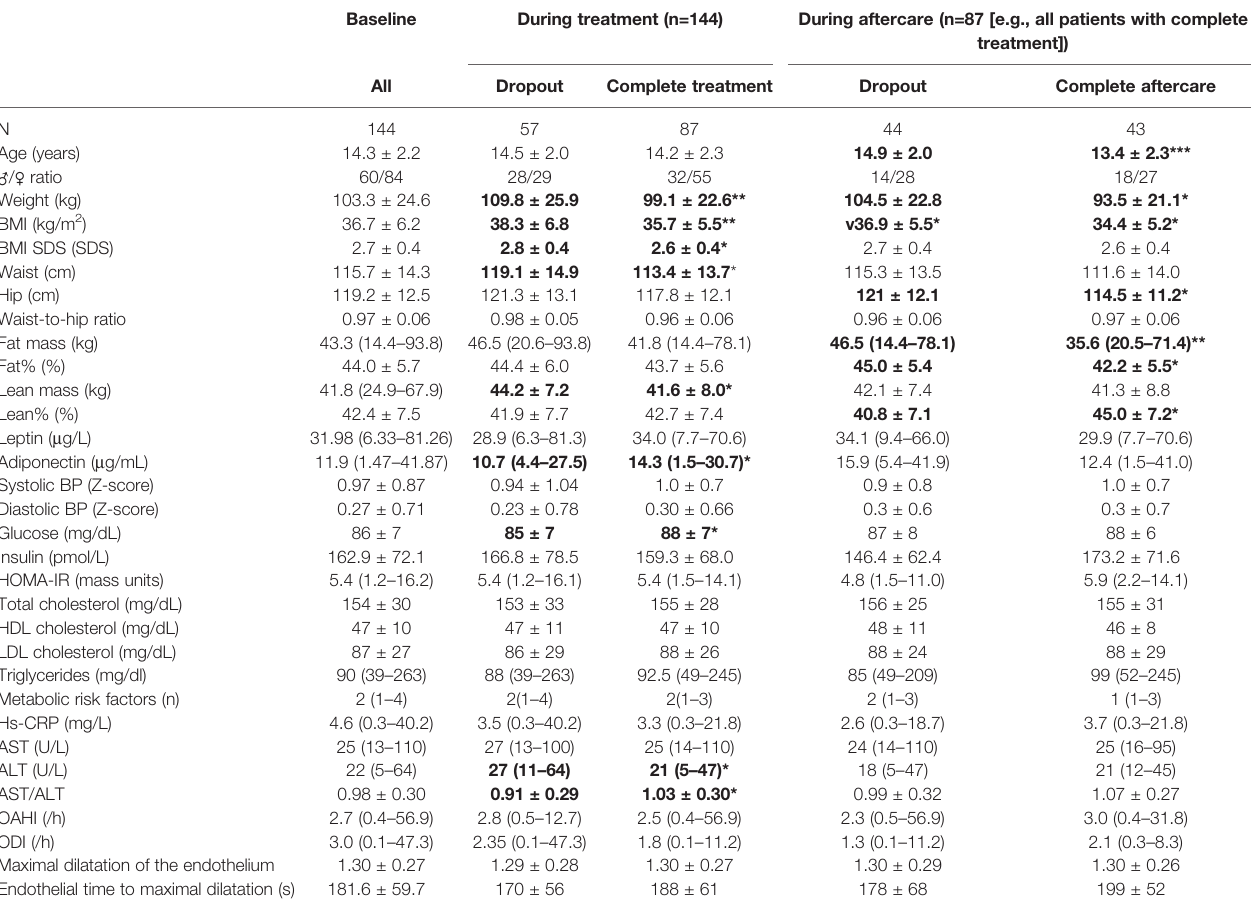
The parameters in bold are signi fi cantly different between groups. *signi fi cantly different between groups p ≤ 0.05, ** signi fi cantly different between groups p ≤ 0.01, *** signi fi cantly different between groups p ≤ 0.001. AST, aspartate aminotransferase; ALT, alanine aminotransferase; BMI, body mass index; BP, blood pressure; HDL, high-density lipoprotein; HOMA-IR, homeostatic model for the assessment of insulin resistance; hs-CRP, high-sensitivity C-reactive protein; LDL, low-density lipoprotein; OAHI, obstructive apnea – hypopnea index; ODI, oxygen desaturation index; SDS, standard deviation